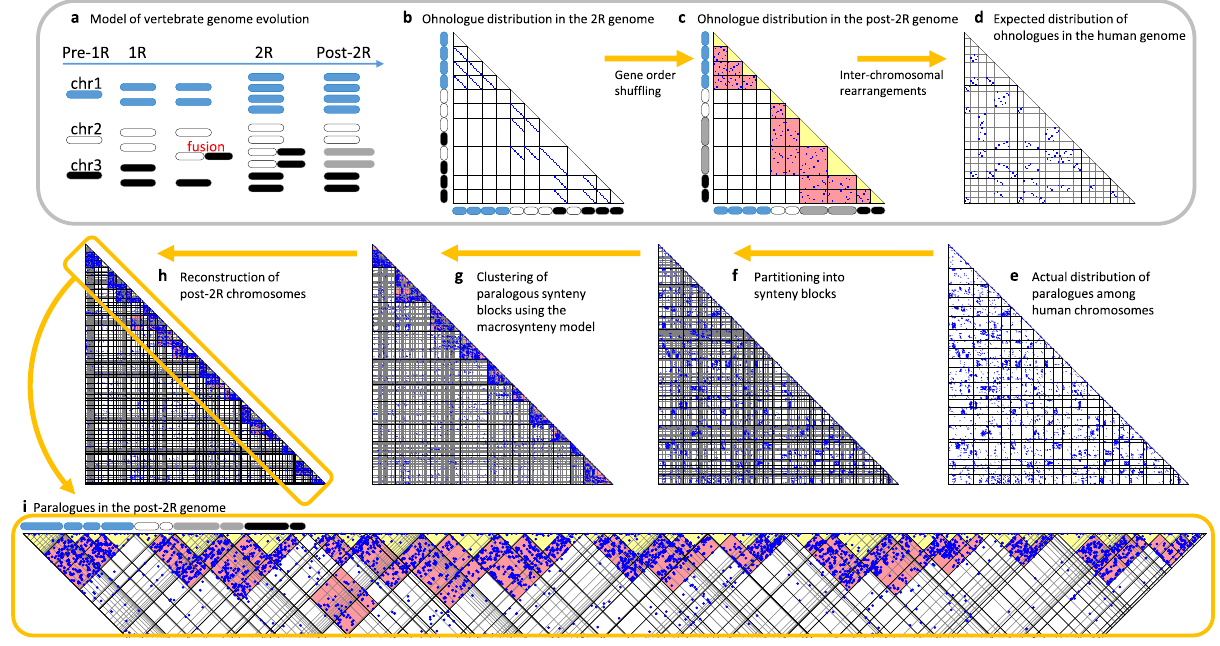
Fig. 4 Model of vertebrate genome evolution and reconstruction of proto-gnathostome chromosomes. a Hypothetical scenario of an ancestral genome of three chromosomes that experiences two rounds of WGD (labelled 1R and 2R) and rearrangements. b Scatter plot of ohnologues created by the two WGD events. The hypothetical 2R genome is along each axis. Dots represent ohnologue pairs whose genome positions are indicated by the x - and y -axes. c Inversions result in extensive shuf fl ing of gene order within a chromosome, scattering the dots over the entire chromosome. Red rectangles indicate regions that contain many ohnologue gene pairs between duplicated chromosomes. Yellow triangles represent intra-chromosome comparisons and are empty. d Inter-chromosomal rearrangements shuf fl e the genome further. The aim of our reconstruction analysis is to infer the post-2R genome structure ( c ) from modern genomes ( d ). e As expected, the actual ohnologue distribution in the human genome is similar to Panel d . Lines indicate chromosome boundaries, and human chromosomes 1 – 22, X and Y are ordered along the axes. f The human chromosomes were partitioned into 151 segments of conserved synteny based on comparison with other gnathostome genomes. g The segments were grouped into 10 clusters (red triangular regions) using the probabilistic macrosynteny model. Segments in individual clusters are expected to derive from a single pre-1R chromosome (no fusions), or alternatively derive from multiple pre-1R chromosomes if they involve fusions. h Optimal partitioning of each cluster of human segments into several paralogous subgroups (yellow triangles of low ohnologue density, representing 49 post-2R chromosomes). i Magni fi cation of the diagonal part of h . Examples of fusion presence/absence similar to panel a are present, indicated by the chromosome cartoons above the plot shaded as per panel a . For example, the leftmost group of segments make up the Hox-bearing chromosomes and have not experienced fusion (blue